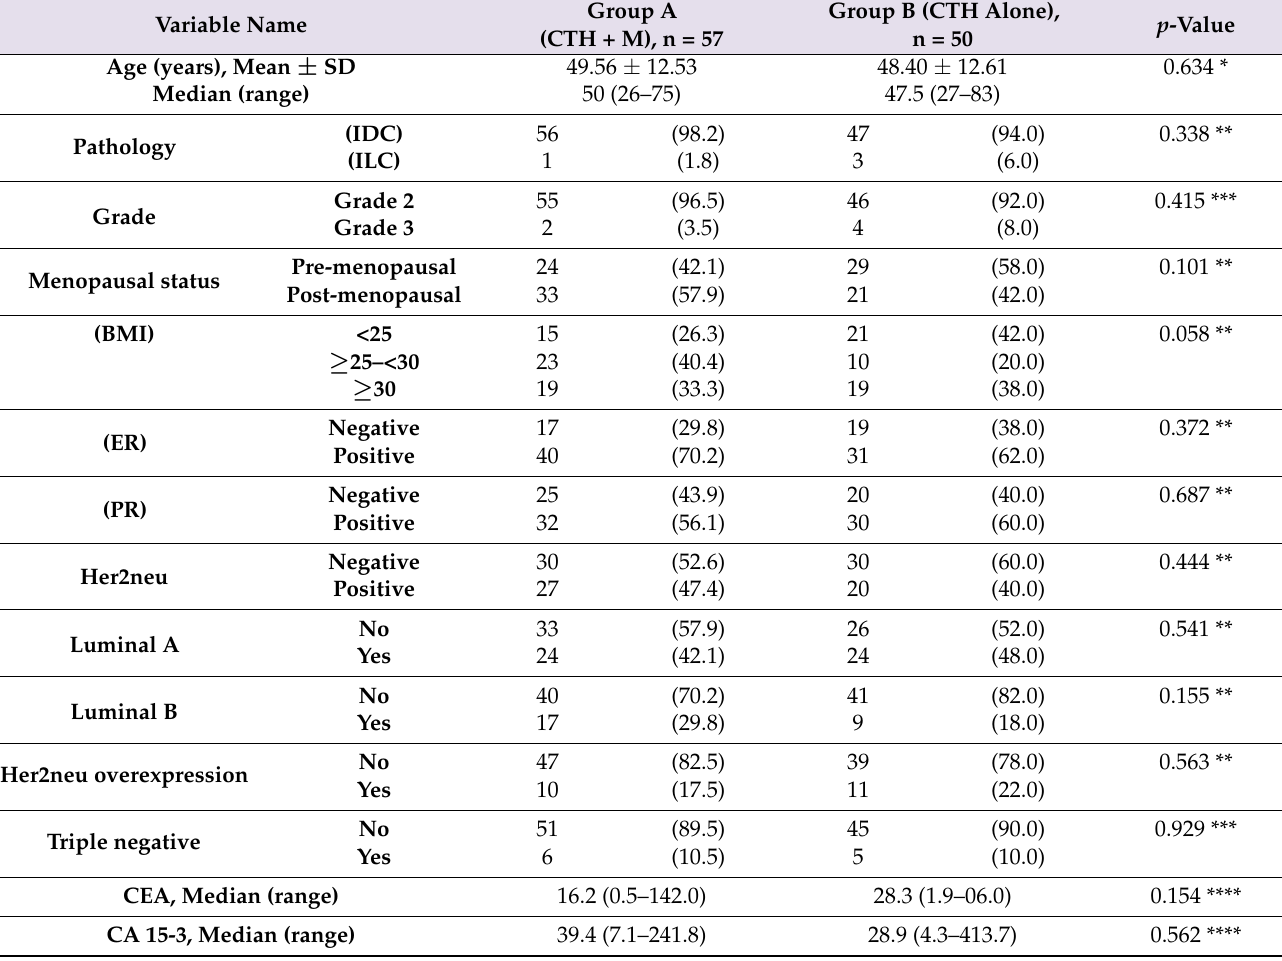
Table 1. Baseline patient characteristics (n =